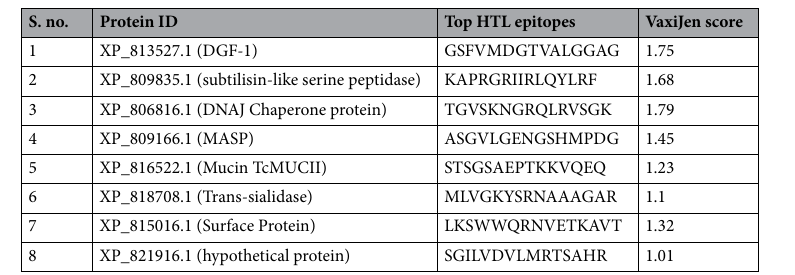
7 XP_815016.1 (Surface Protein) LKSWWQRNVETKAVT